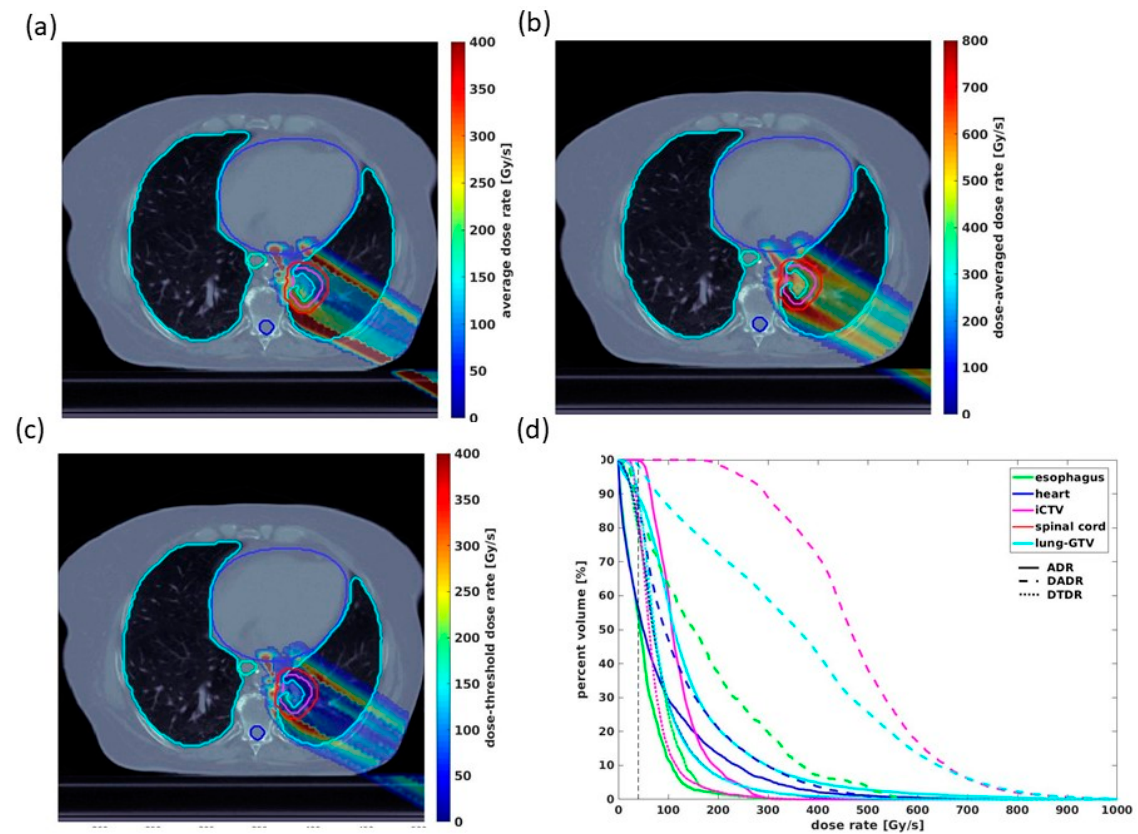
Figure 2. An axial slice of one field of the 3D dose rate distribution of one Bragg-peak plan corresponding to ( a ) ADR, ( b ) DADR, and ( c ) DTDR calculations. ( d ) DRVHs of the three-dose-rate, indicating differences in the dose rate distributions, with intersections of the 40 Gy/s dose rate threshold plotted by the dashed line.